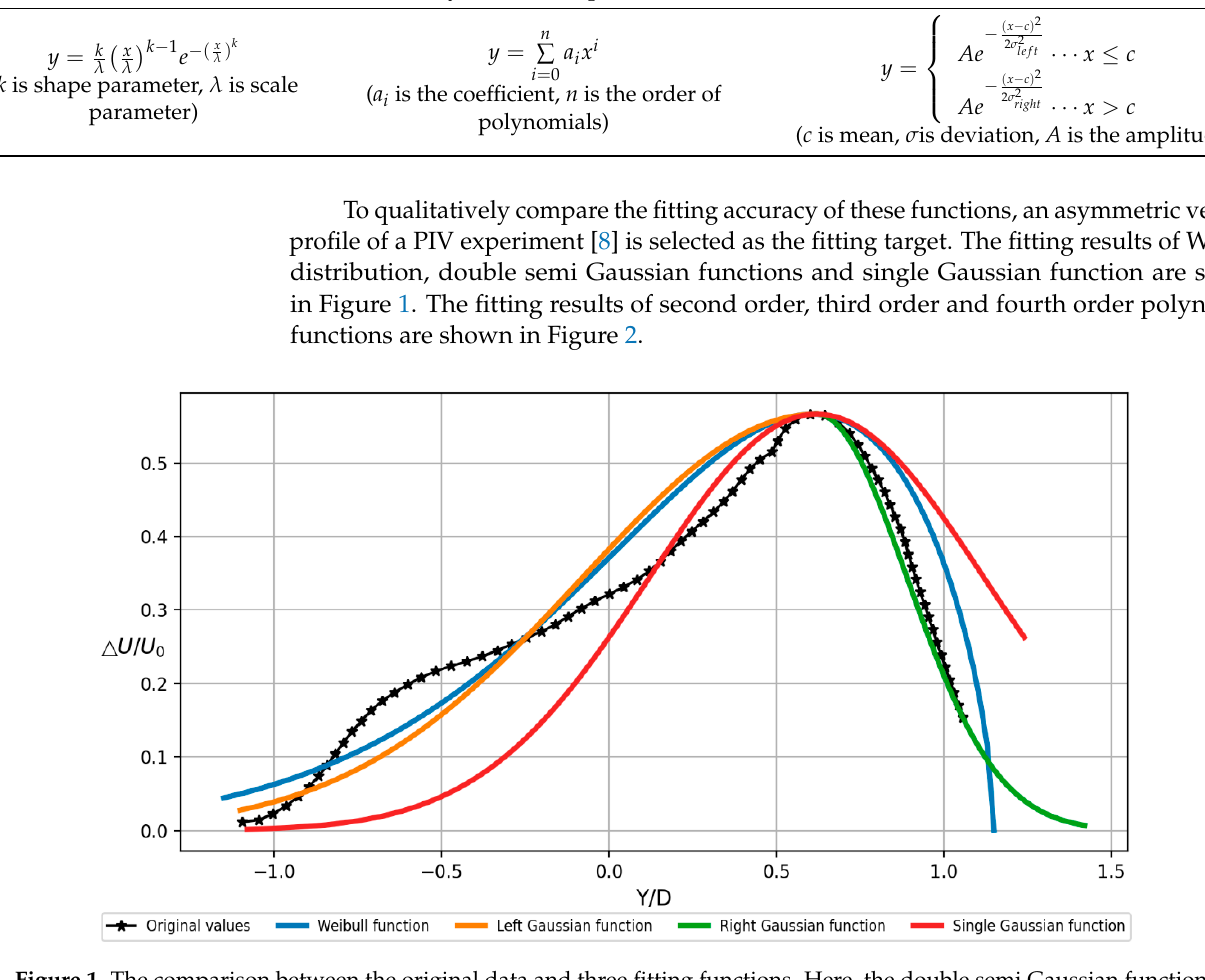
Figure 1. The comparison between the original data and three fitting functions. Here, the double semi Gaussian functions are divided into left Gaussian function and right Gaussian function. The original data is the velocity profile at 3D position in a PIV experiment [8]. X -axis is the position of cross-section which is normalized by the diameter D . Y -axis is the velocity deficit which is normalized by the inlet velocity U 0 . (The deviation of left Gaussian is 0.7, the deviation of right Gaussian is 0.27, the parameters of Weibull function: k = 1.6, λ = 1. The deviation of single Gaussian is